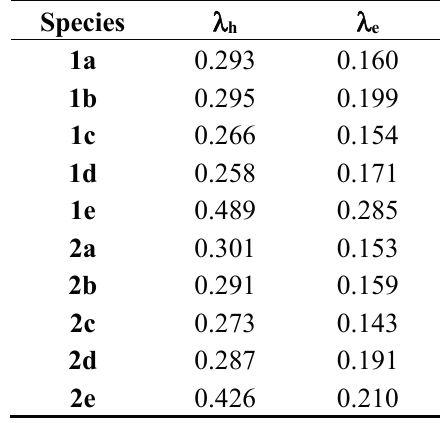
Table 3. Calculated λ e and λ h (both in eV) of the compounds under investigation at the B3LYP/6-31G(d,p)